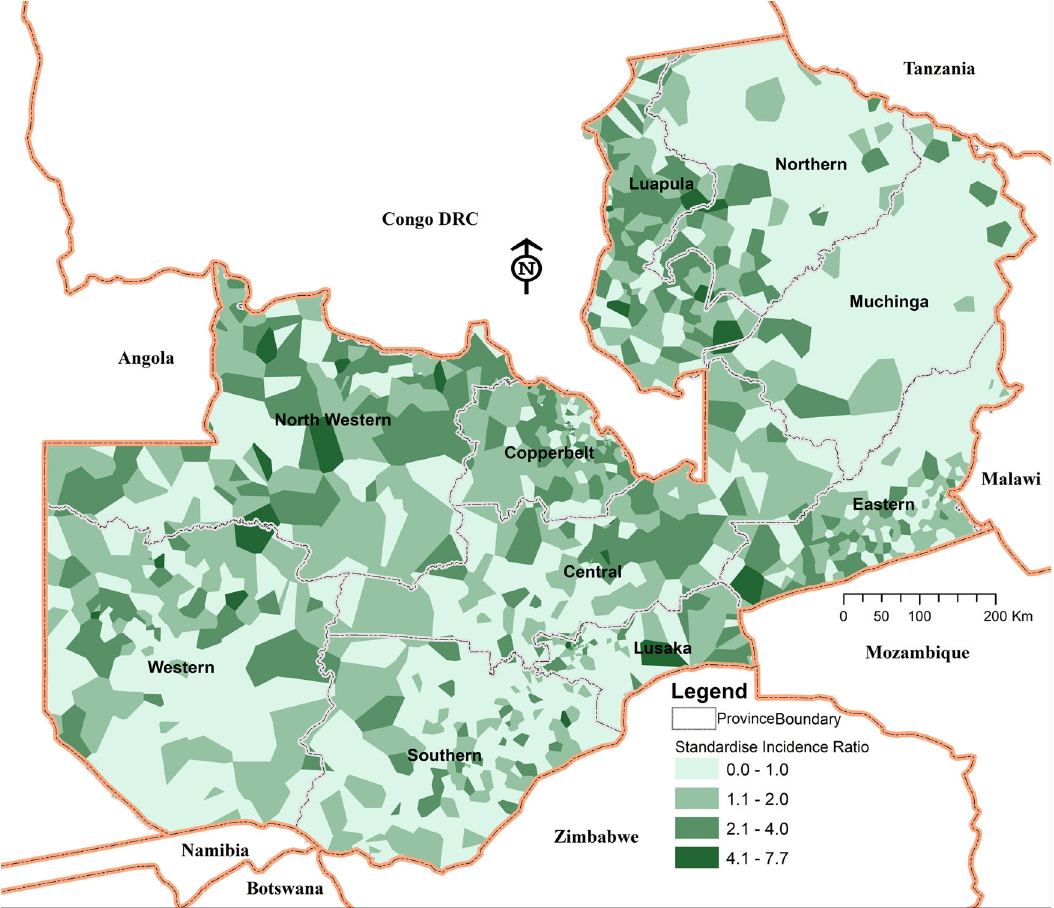
Fig. 4 Standardised malaria mean risk ratio, 2009 – 2015. The colour indicates the mean standardised incidence ratio. Lighter shades indicate lower risk ratio values, while darker shades indicate a higher